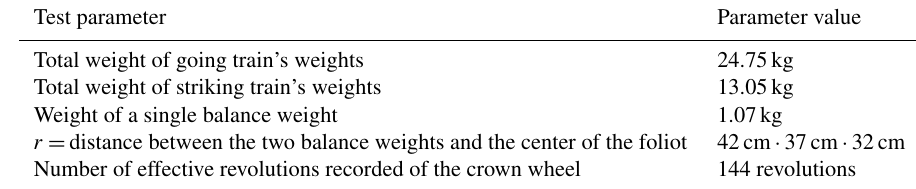
Table 4. Parameters used for the foliot swinging period’s experimental test.